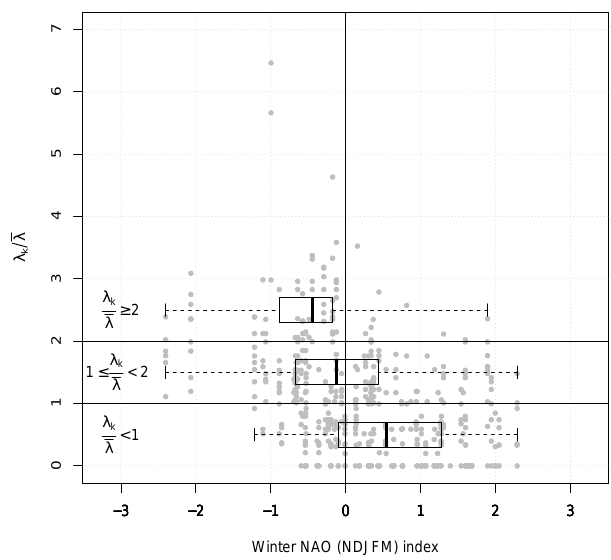
Fig. 11. Samples S1 to S10. Number of floods in a hydrologic year divided by the mean number, λ k /λ , of all the mean daily flow samples plotted together against the winter NAO (NDJFM) index of year k .